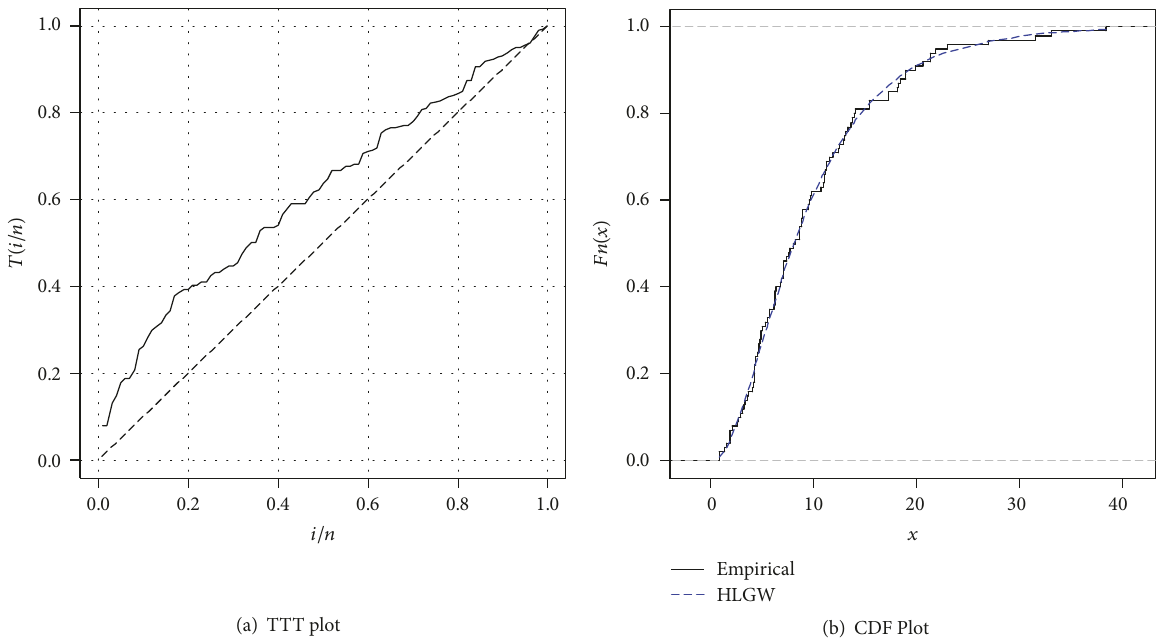
Figure 4: TTT plot and CDF plot for the waiting time